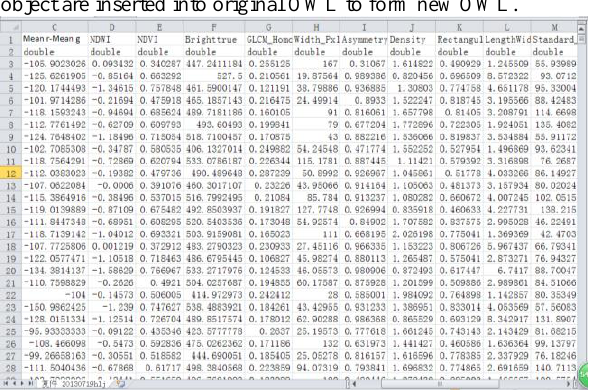
Figure 8. Feature table in csv style.